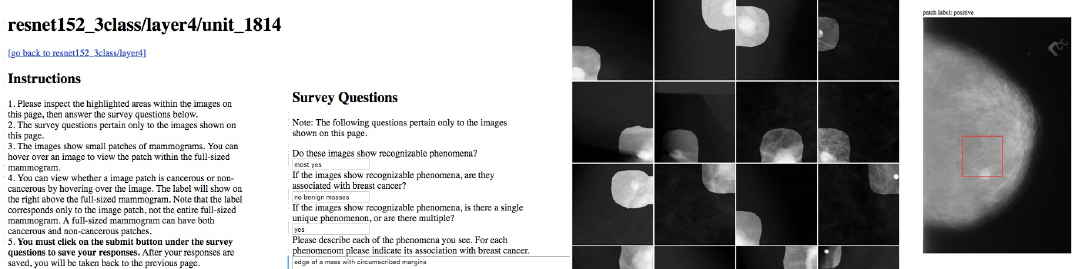
Figure 2. The interface of the DeepMiner survey: Experts used this survey form to label influential units. The survey asks questions such as: “Do these images show rec- ognizable phenomena?” and “Please describe each of the phenomena you see. For each phenomenon please indicate its association with breast cancer.” In the screenshot above, the radiologist who was our expert-in-the-loop has labeled the unit’s phenomena as ‘edge of mass with circumscribed